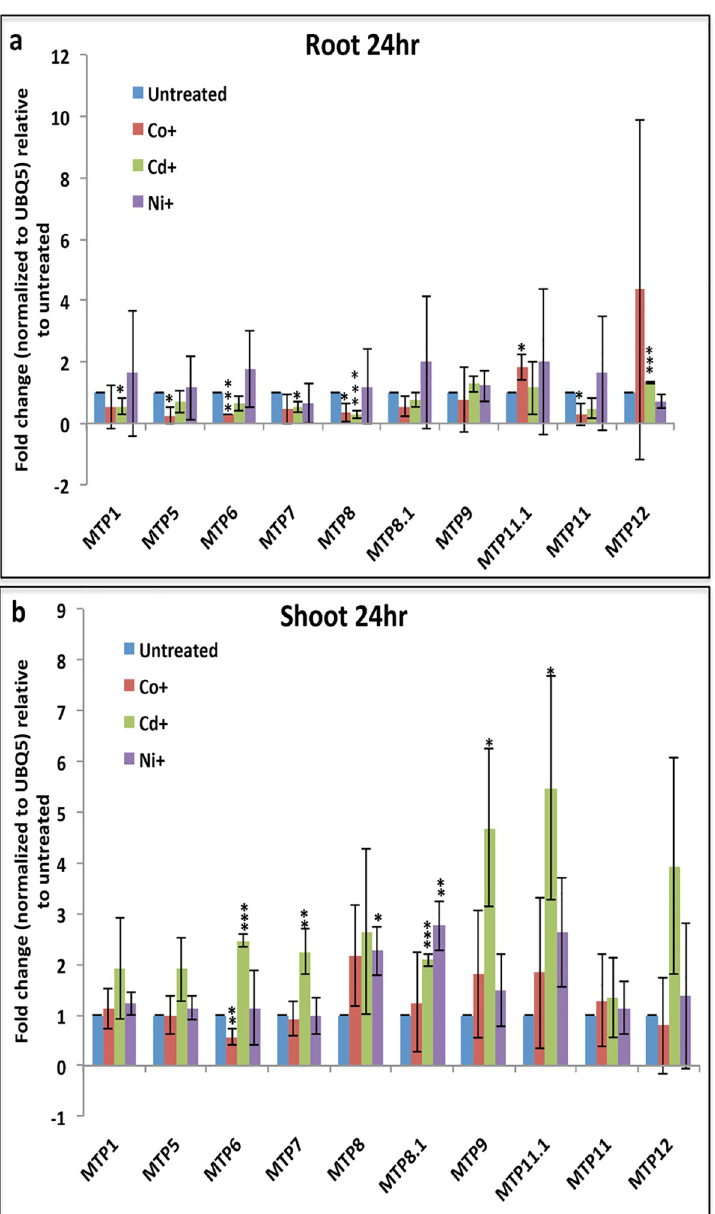
Ni. The fold change is calculated against untreated samples. Asterisks indicate Student’s T-test results, where � = p < 0.05, �� = p < 0.01, ��� = p <